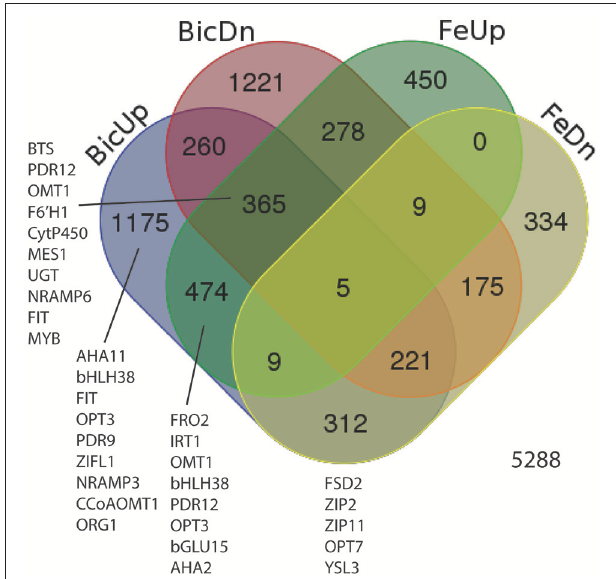
FIGURE 4 | Venn diagram showing differentially expressed genes (DEGs) in roots of IDC sensitive or tolerant soybean lines (genotypes combined). BicUp, DEGs upregulated by 2.5 and/or 5mM bicarbonate treatment relative to 0 bicarbonate; BicDn, DEGs downregulated by bicarbonate treatment; FeUp, DEGs upregulated by low Fe (1 µ M) treatment relative to normal Fe (25 µ M) treatment; FeDn, DEGs downregulated by low Fe (1 µ M) treatment. Numbers represent number of elements (genes) in each set. Genes of interest in each set are listed near the set, and correspond to highlighted genes in Supplementary Table 2